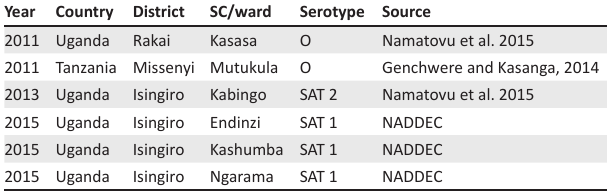
TABLE 1: Foot-and-mouth disease serotypes responsible for some of the outbreaks between 2011 and 2016 in the districts at the border of Uganda and